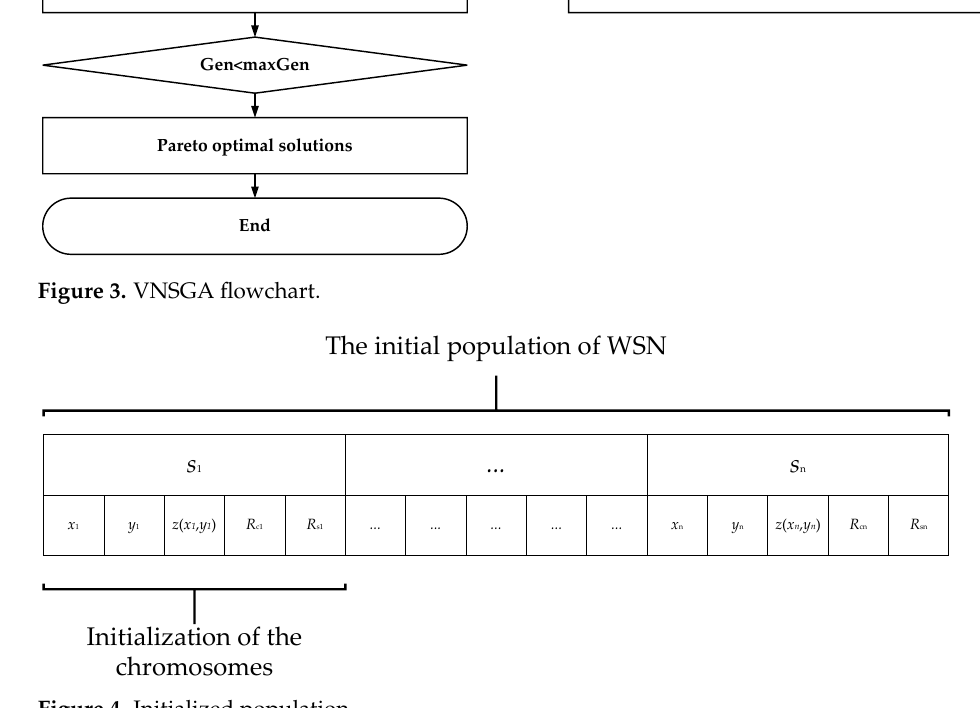
Figure 4. Initialized population.